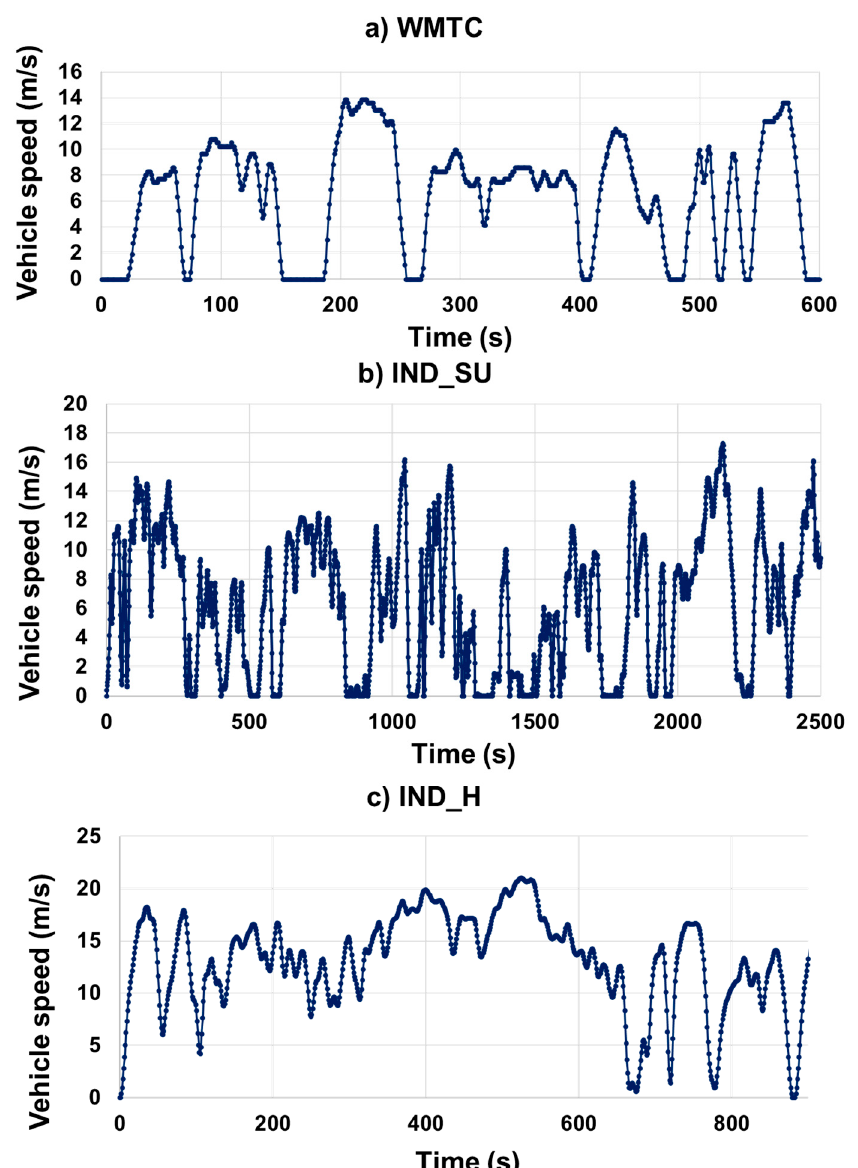
Figure 6. Drive cycles considered for training ( a ) WMTC, ( b ) IND_SU and ( c ) IND_H.